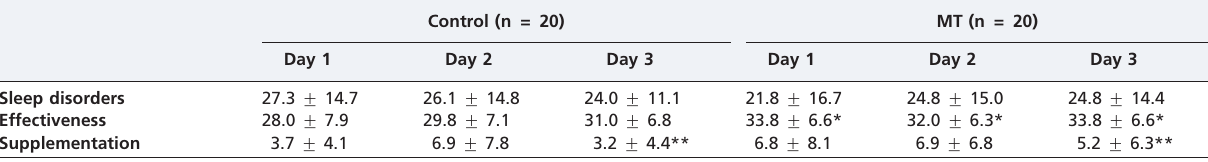
Table 2 - VAS of sleep scores in the control and MT groups during the study period.